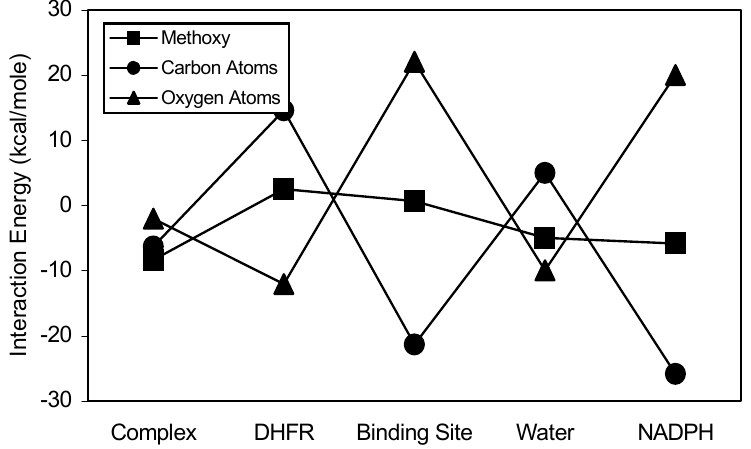
Figure 4 . Comparison of the interaction energy analyses of the methoxy region of PTX and its carbon and oxygen